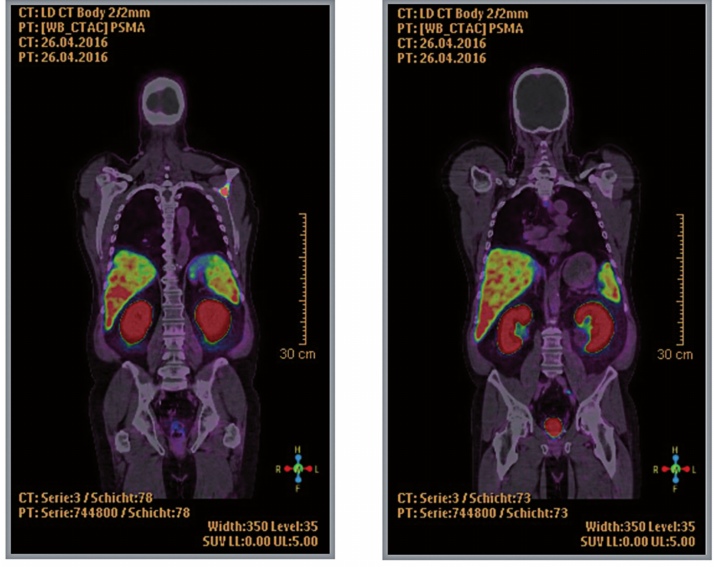
Figure 2 - Patient 1, second scan, left: osseous metastasis in the scapula, right: lymph node in the left iliac region.